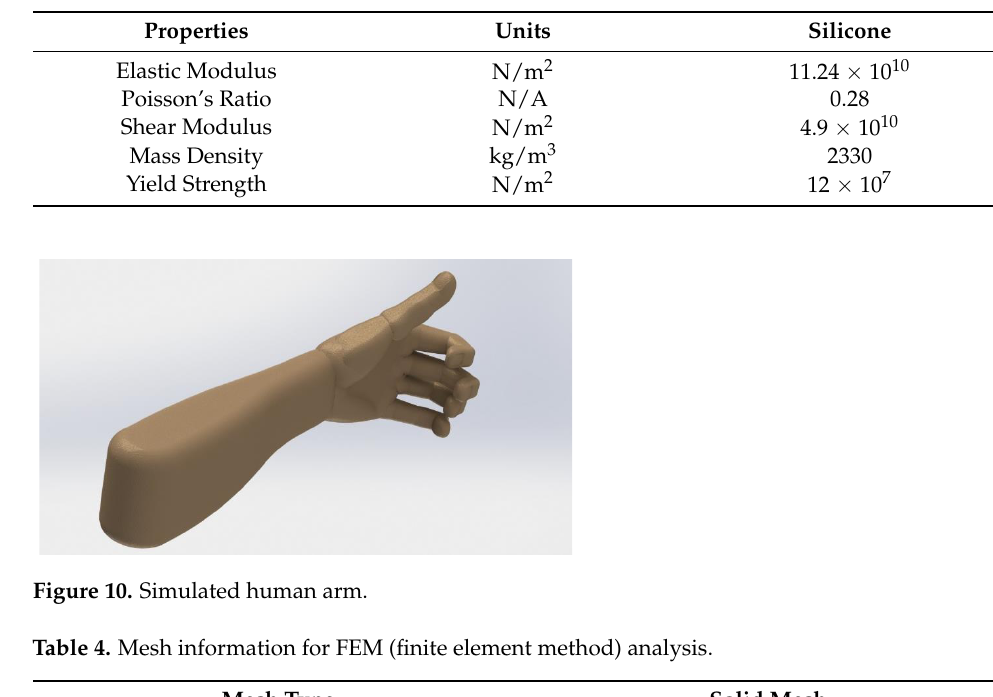
Table 3. Material characteristics of the used silicone material.